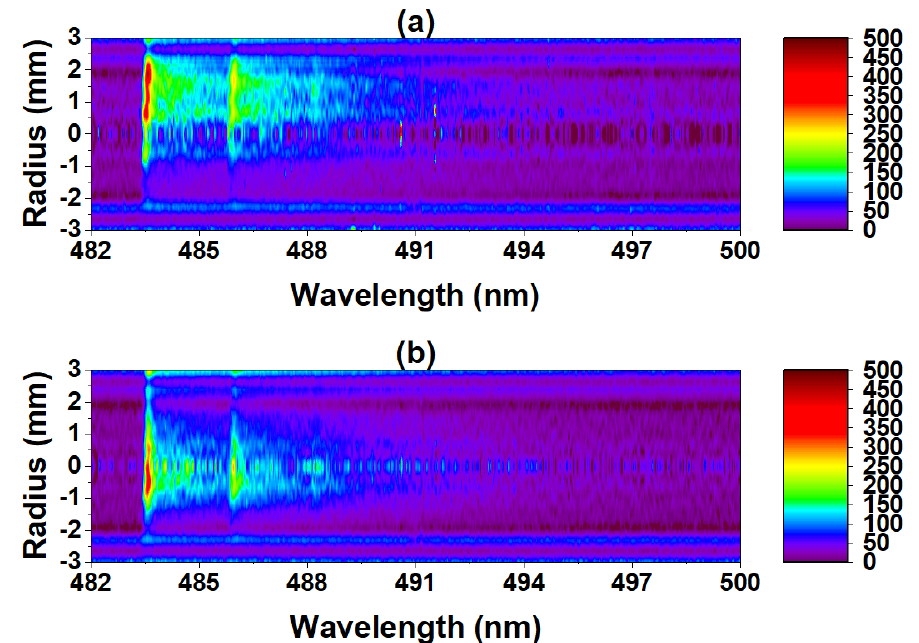
Figure 2. Contour mappings of extracted radial deconvolutions of measured AlO spectra at ( a ) 20 µ s and ( b ) 35 µ s time